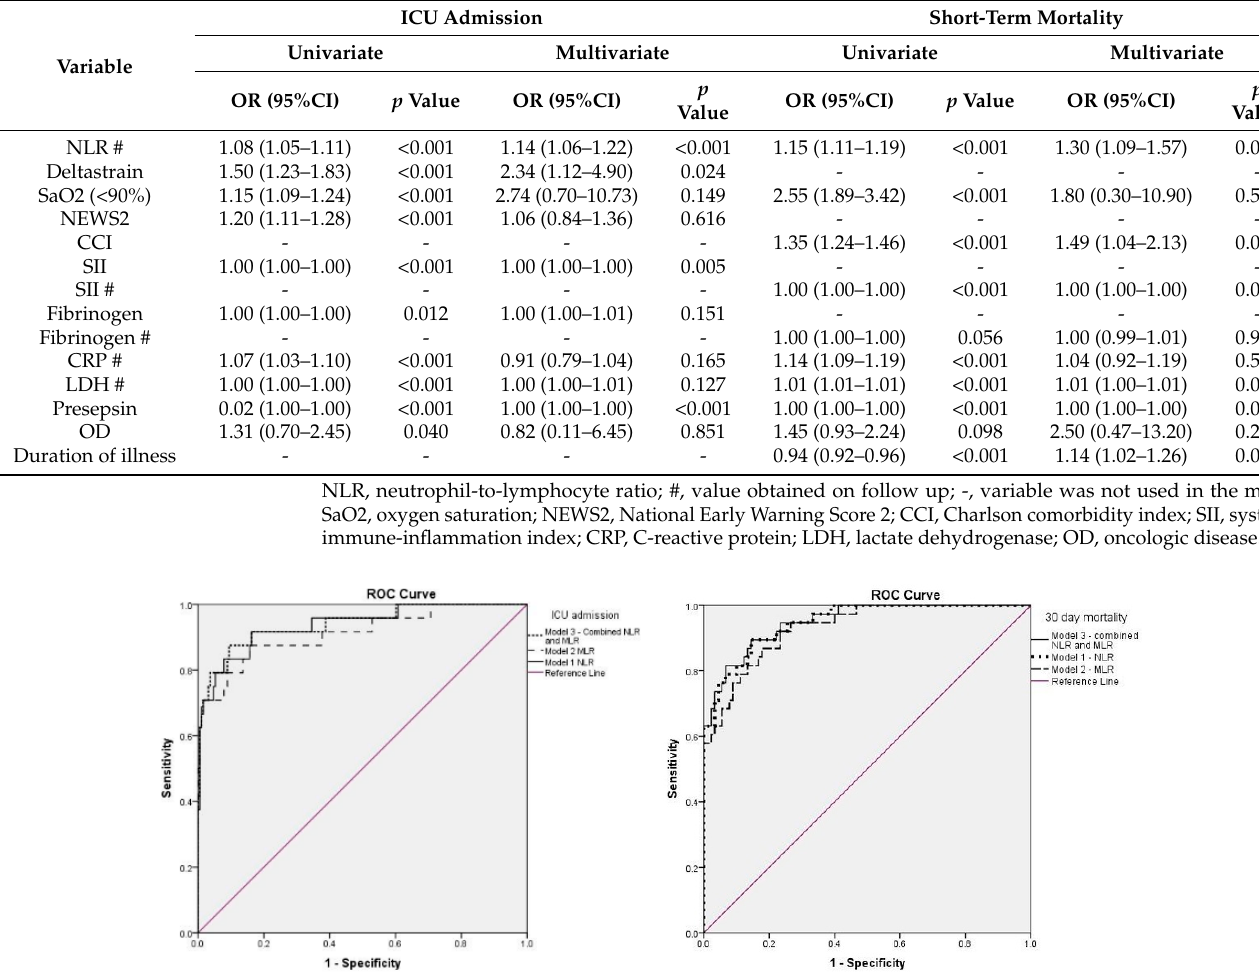
Table 2. Logistic regression models for the main outcomes’ prediction including follow-up NLR.